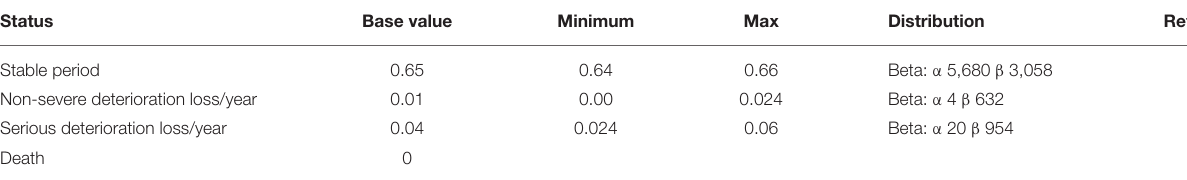
TABLE 2 | Model utility parameters.